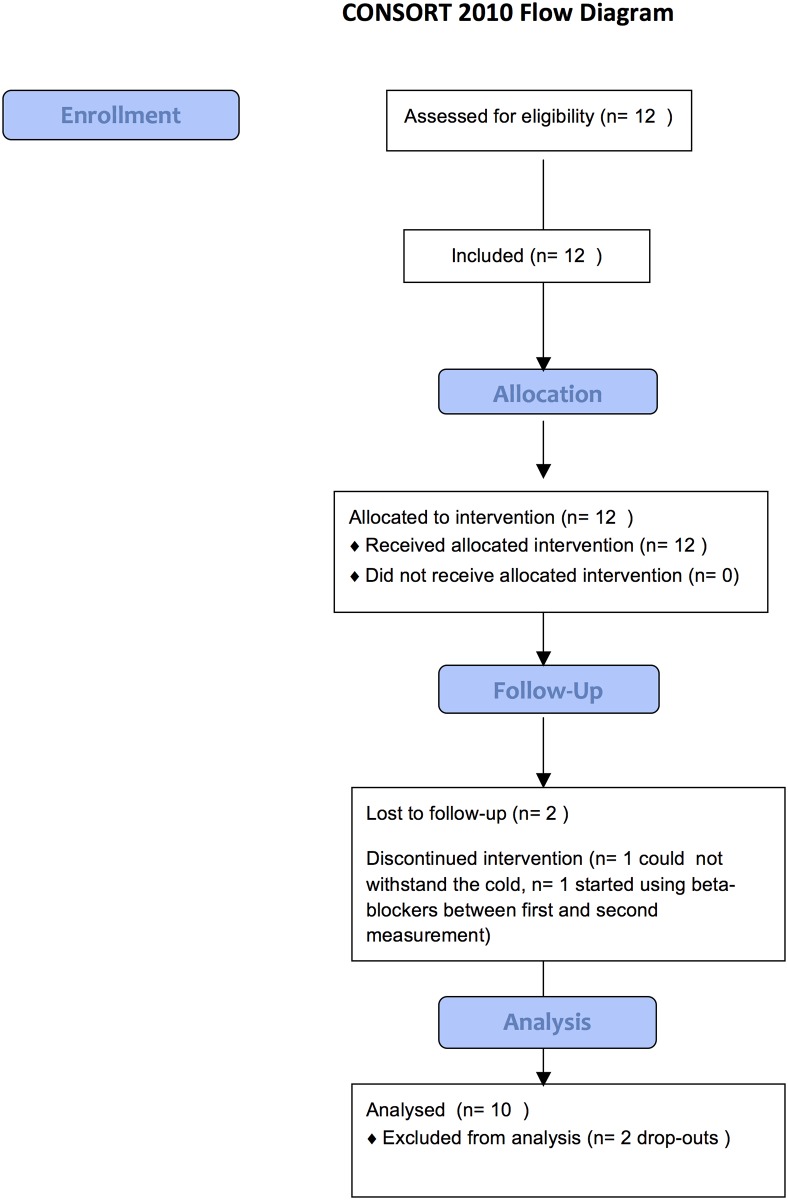
Consort 2010 flow chart.